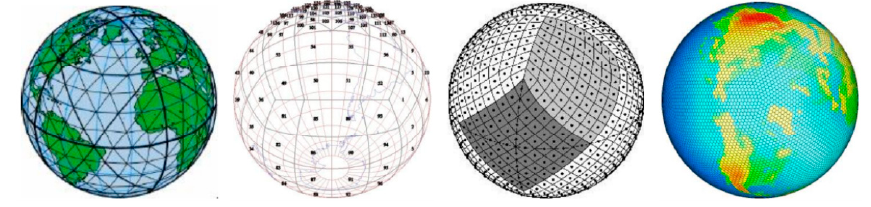
Figure 1. Typical subdivision grids.